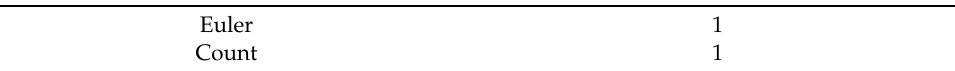
Table 13. First decomposition type—distribution of combinatorial Euler characteristics of point complexes from border interior overlay.